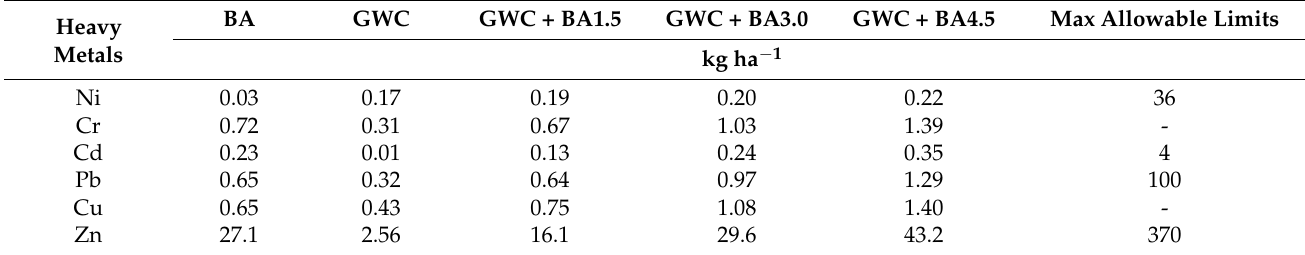
Table 4. The amount of heavy metals (Ni, Cr, Cd, Pb, Cu and Zn) introduced into the soil (kg ha − 1